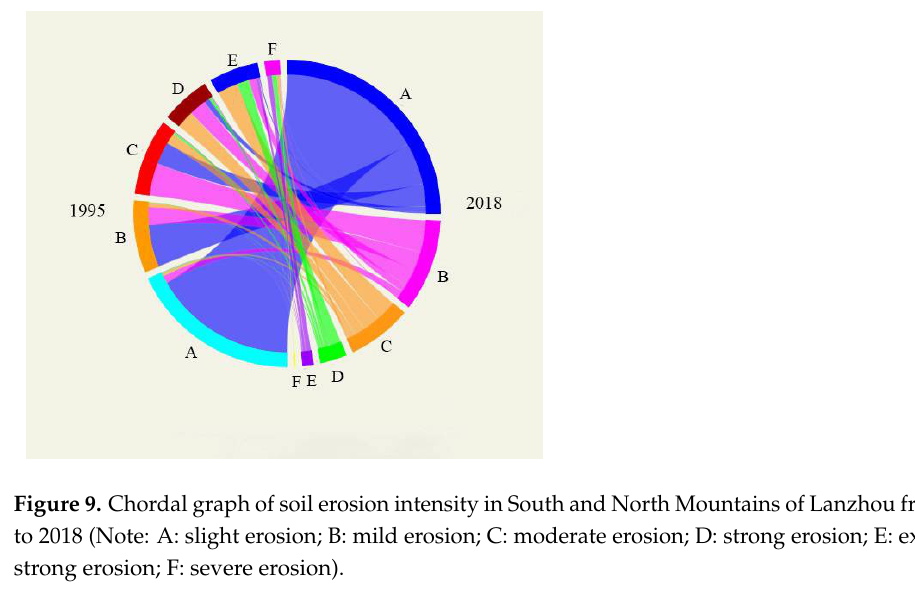
10 of 16 Figure 8. Spatial distribution of soil erosion intensity in the South and North Mountains of Lanzhou in 1995, 2000, 2005, 2010, 2015 and 2018. 3.3. Area Transfer Characteristics of Soil Erosion Intensity Based on the statistical analysis of the data of different erosion intensity areas, the transfer chord diagram of soil erosion intensity was obtained. From 1995 to 2018, the area of soil slight erosion was the largest, which was 735.92 km 2 , followed by mild, moderate, strong, extremely strong, and the area of severe erosion remained the smallest. Among them, slight soil erosion mainly shifted to mild soil erosion. The mild soil erosion trans- ferred to slight soil erosion, and the area was 215.14 km 2 ; moderate soil erosion mainly